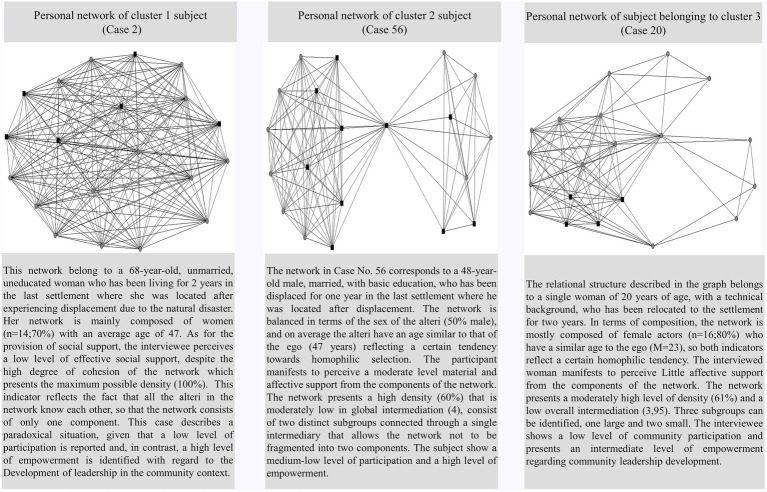
Example of a network per cluster.